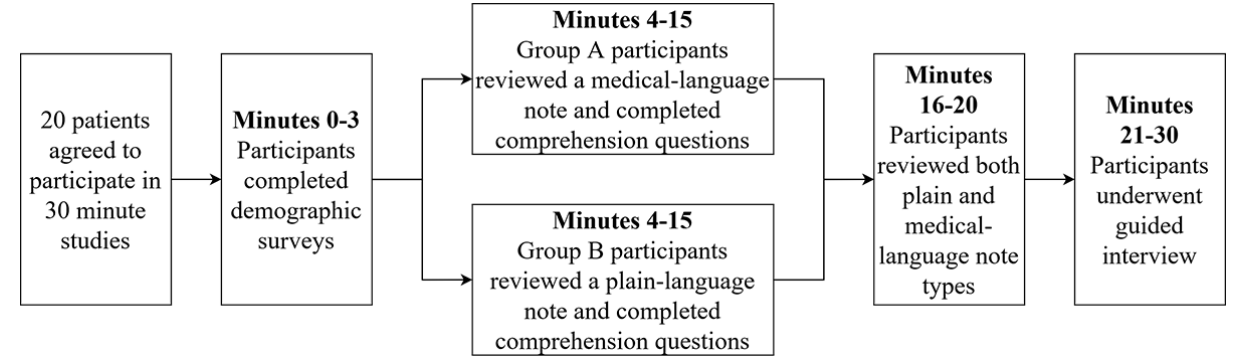
Figure 1. Participant assessment and interview